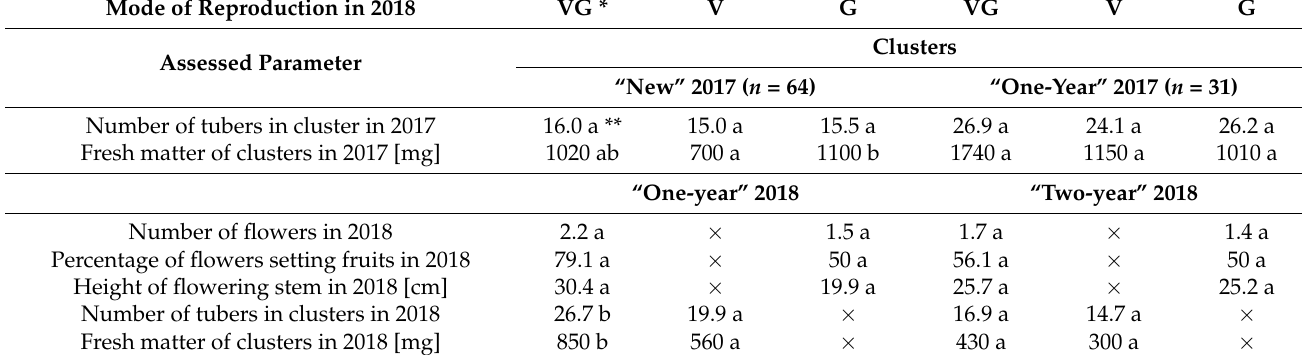
Table 3. The size of tuber clusters and the reproduction mode for two age groups of clusters in the year 2018 and their effect on selected traits related to the efficiency of generative and vegetative propagation.